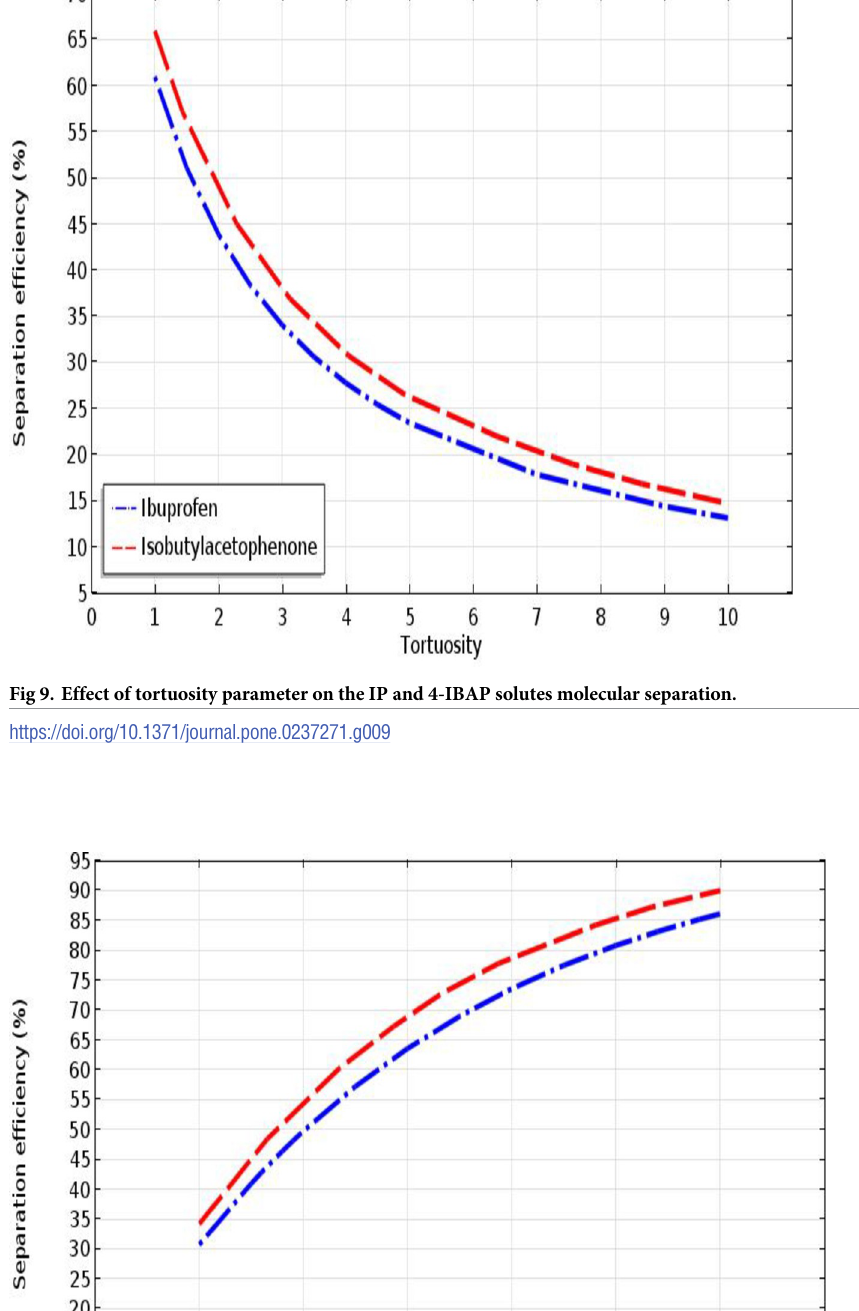
PLOS ONE | https://doi.org/10.1371/journal.pone.0237271 August 31,